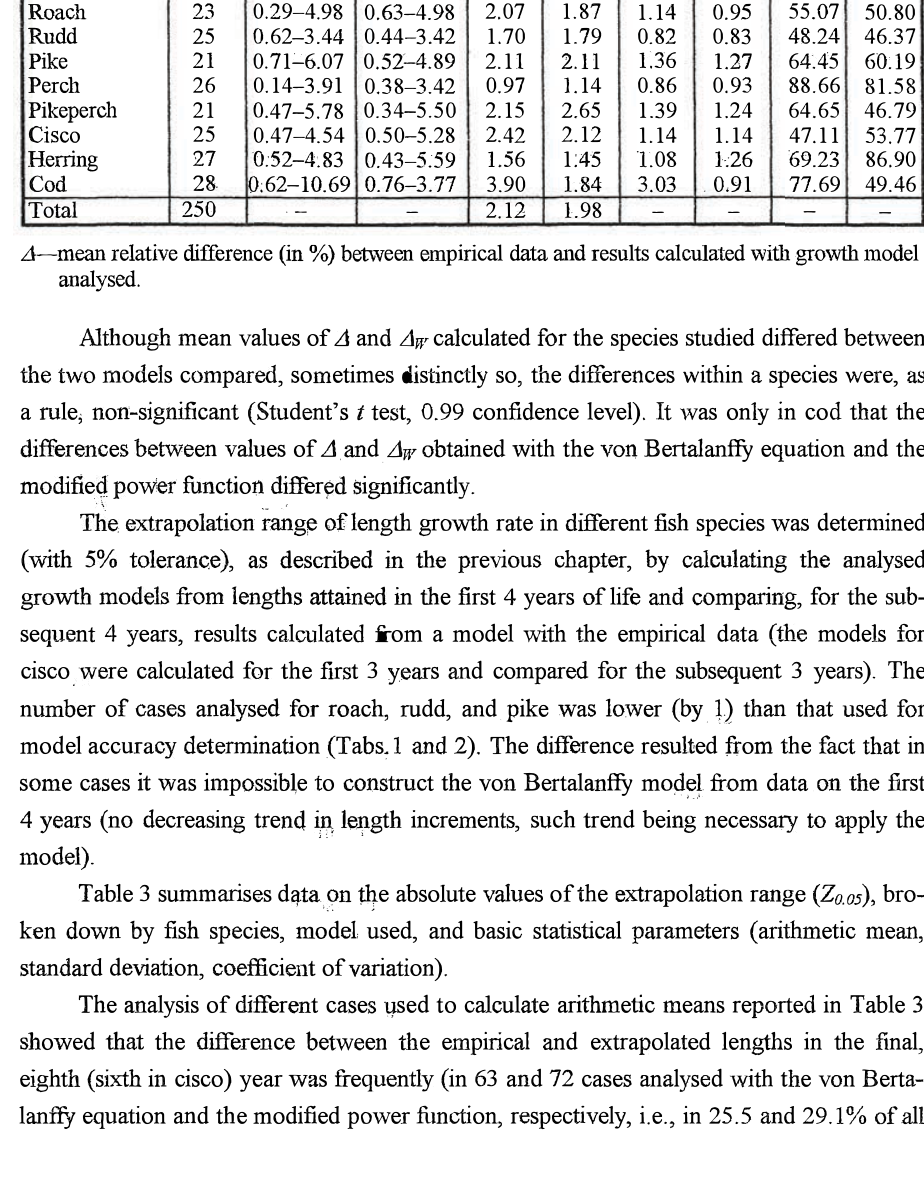
Comparison of relative accuracy ofvon Bertalanffy equation (a) and modified power :function (b) used for mathematical description of length growth in various